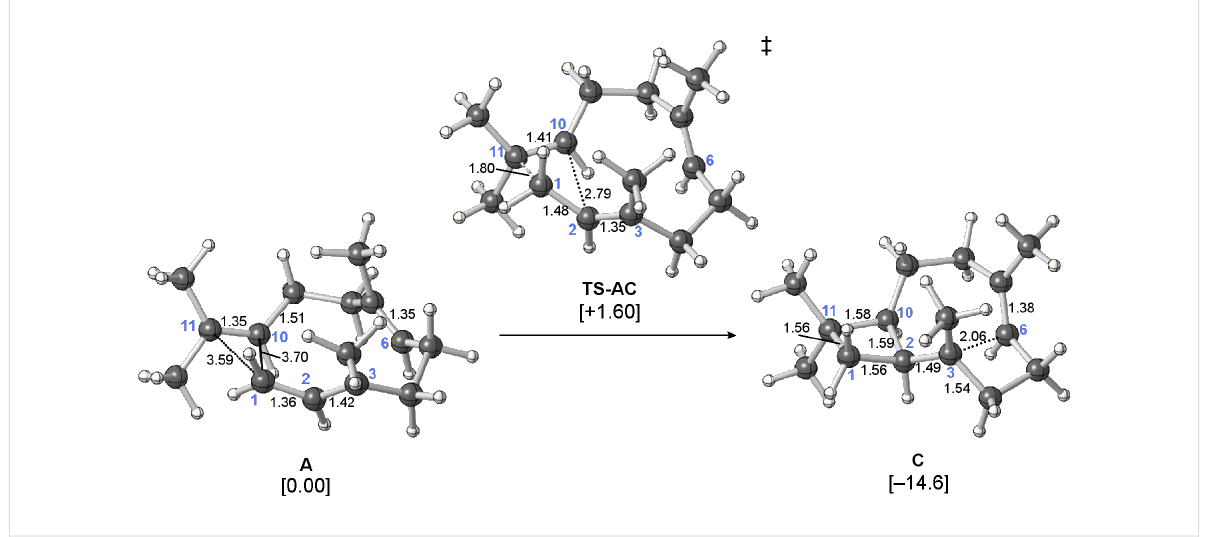
Figure 3: Computed minima and transition-state structure involved in the single-step conversion of A to C . Relative energies shown (kcal/mol) were calculated at the mPW1PW91/6-31+G(d,p)//B3LYP/6-31+G(d,p) level.